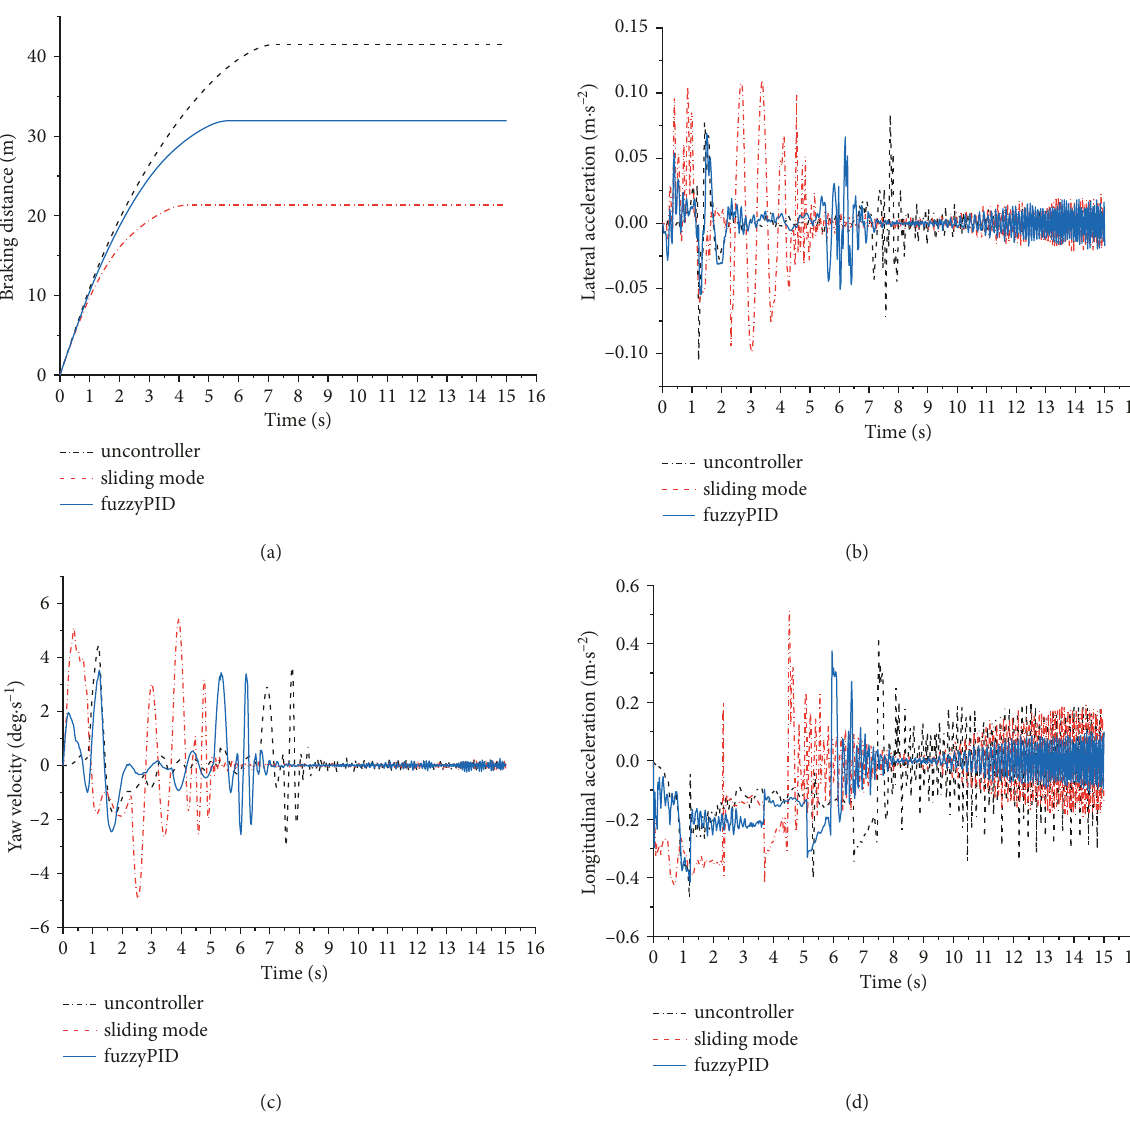
Figure 15: Simulation comparison diagram of different controls in long downhill with u � 0.9. (a) Braking distance. (b) Lateral acceleration. (c) Yaw velocity. (d) Longitudinal